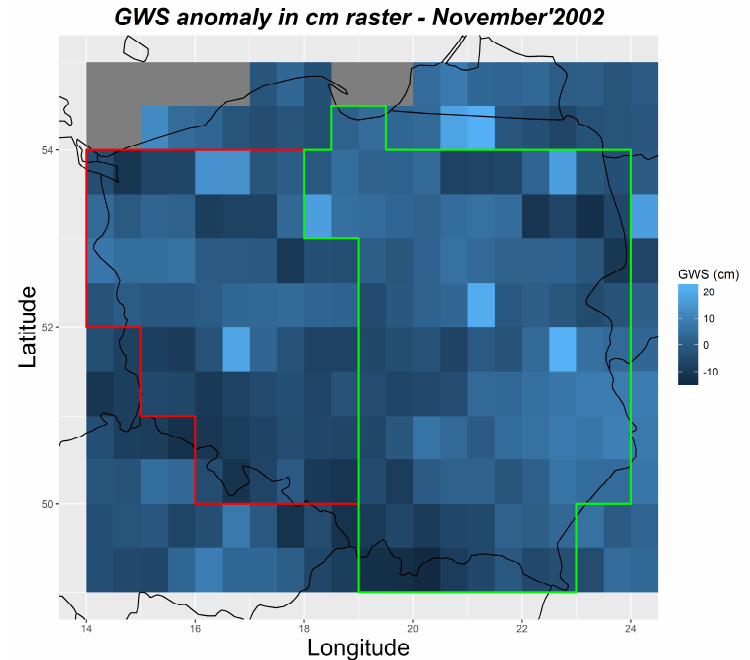
Figure 2. Groundwater storage (GWS) raster computed for November 2002, with marked areas used for averaging (green: Vistula basin, red: Odra basin).